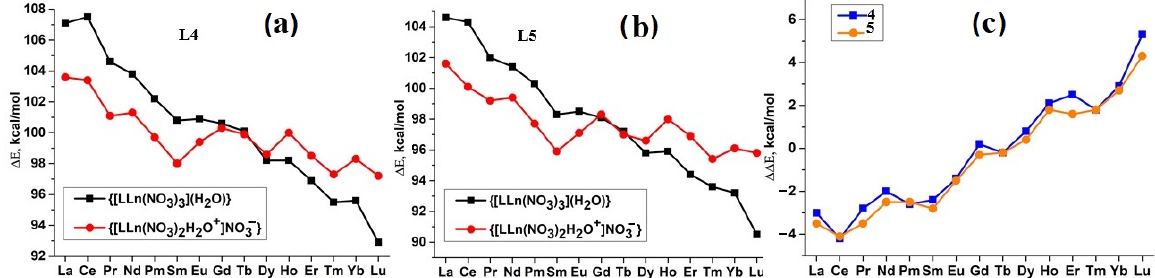
Figure 7. Calculated ∆E of formation of complexes ( B ) and ( A ) with L4 ( а ) and L5 ( b ); ∆∆E B,A for Ln cations ( c ).